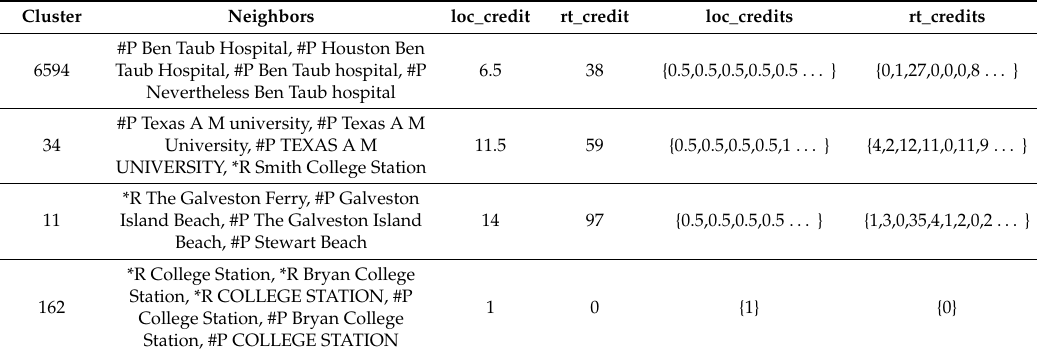
Figure 7. Detected space–time clusters in College Station and Houston regions: ( a ) Study area; ( b ) college station region; ( c ) clusters in the Houston region, with different sizes of red bubbles indicating different sizes of spacetime aggregation. Table 3. Event table with credibility score.